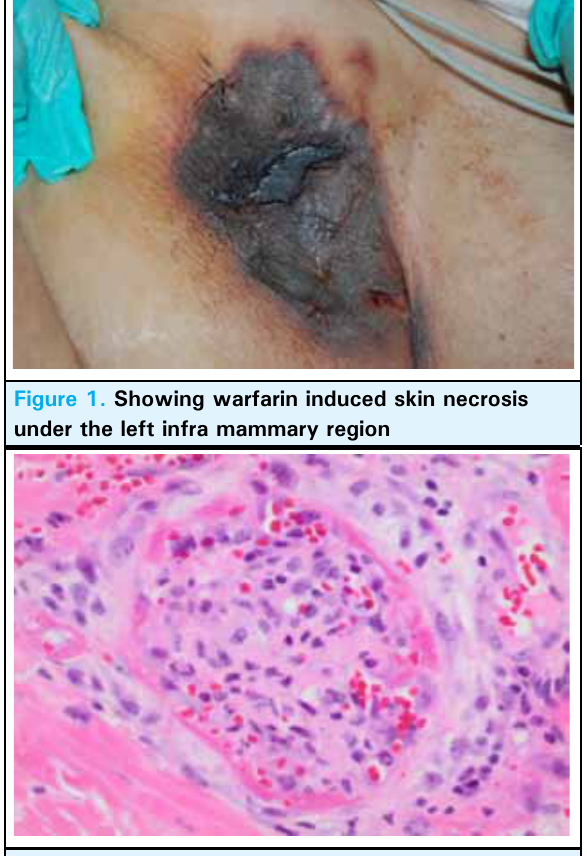
Figure 2. showing Histopathological image of the skin necrosis showing superficial dermal fibrin thrombi, hemorrhage and ischemic changes consistent with warfarin induced skin necrosis